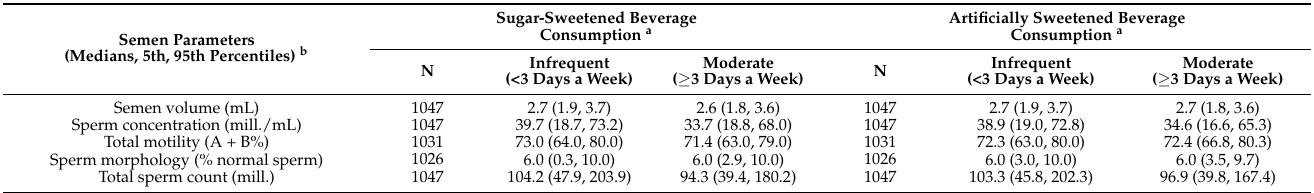
Table 2. Distribution of semen parameters according to low or high consumption of sugar-sweetened and artificially sweetened beverages, FEPOS 2017–2019.